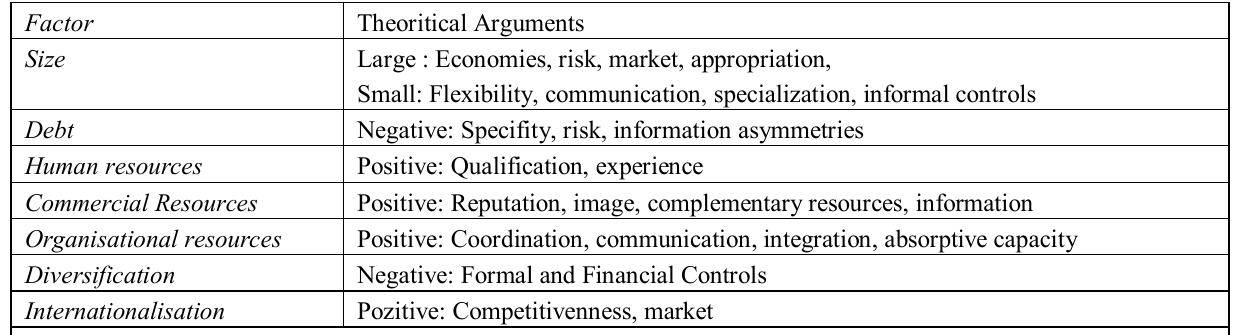
Figure 2 : Internal determinants of the innovative process Table 3: Internal Factors and